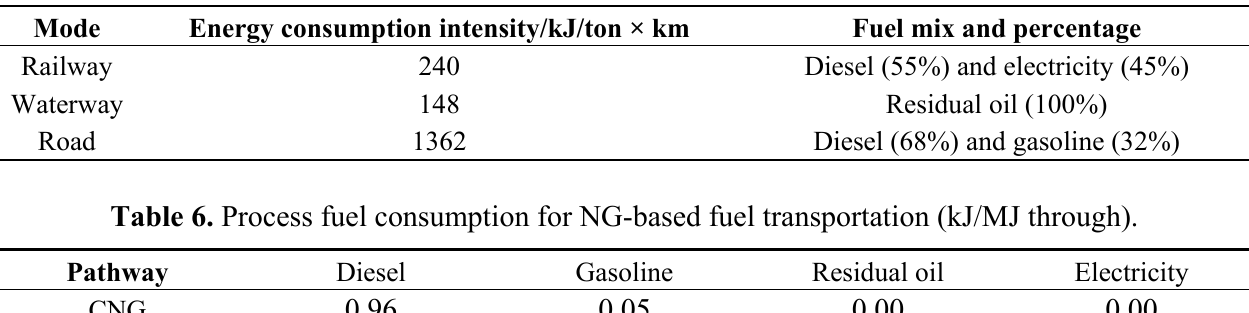
Table 5. Energy consumption intensity and fuel mix for transport.